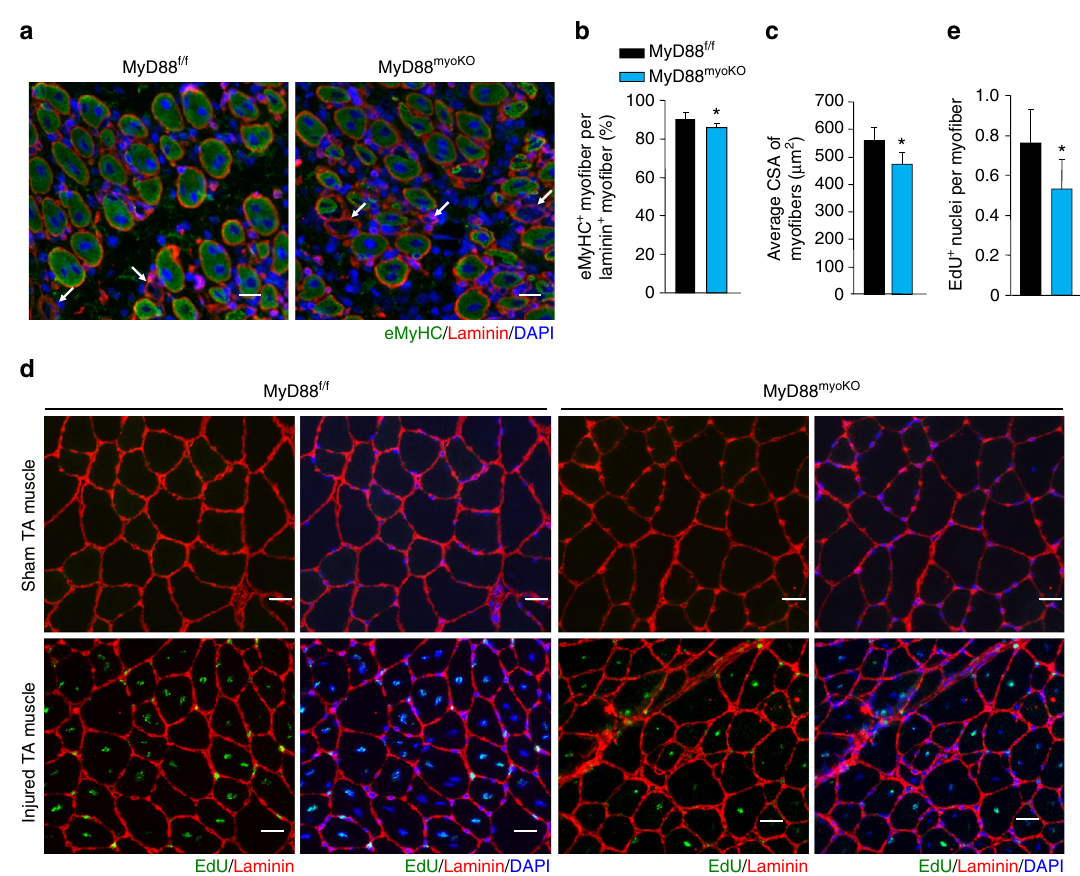
Fig. 6 MyD88 mediates myoblast fusion during skeletal muscle regeneration. a TA muscle of 12-week-old MyD88 f/f and MyD88 myoKO mice was injured by intramuscular injection of 100 µ l of 1.2% BaCl 2 solution. After 5 days, the TA muscle was isolated and immunostained for eMyHC ( green ) and laminin ( red ) proteins. Nuclei were counterstained using DAPI ( blue ). Representative images are presented here. Arrows point to eMyHC − /laminin + fi bers. Scale bar: 50 µ m. b Quanti fi cation of percentage of eMyHC + myo fi bers within laminin staining, and c average CSA of eMyHC + myo fi ber in TA muscle of MyD88 f/f and MyD88 myoKO mice. N = 3 in each group. * p < 0.05 from MyD88 f/f mice by unpaired t -test. In another experiment, TA muscle of MyD88 f/f and MyD88 myoKO mice was injured by intramuscular injection of 100 µ l of 1.2% BaCl 2 solution. After 2 days, the mice were given an intraperitoneal injection of EdU and 11 days later TA muscles were collected and muscle sections prepared were stained to detect EdU, laminin, and nuclei. d Representative photomicrographs after EdU, laminin, and DAPI staining are presented here. Scale bar: 50 µ m. e Quanti fi cation of the percentage of EdU + nuclei per muscle fi ber. N = 5 in each group. Error bars represent s.d. * p < 0.01 from MyD88 f/f mice by unpaired t